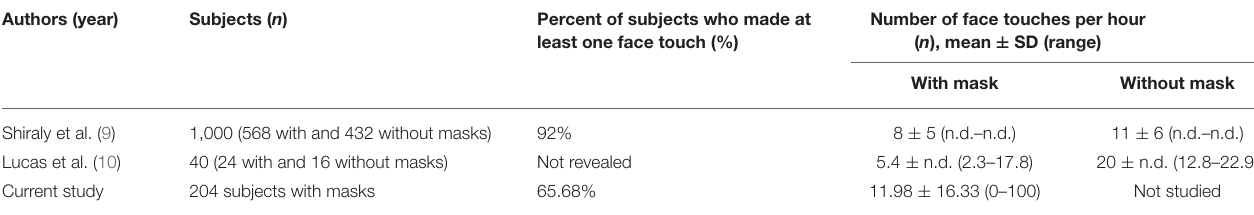
TABLE 2 | Comparison among the series. Authors (year) Subjects ( n ) Percent of subjects who made at Number of face touches per hour least one face touch (%) ( n ), mean ± SD (range) With mask Without mask Shiraly et al. (9) 1,000 (568 with and 432 without masks) 92% 8 ± 5 (n.d.–n.d.) 11 ± 6 (n.d.–n.d.) Lucas et al. (10) 40 (24 with and 16 without masks) Not revealed 5.4 ± n.d. (2.3–17.8) 20 ± n.d. (12.8–22.9) Current study 204 subjects with masks 65.68% 11.98 ± 16.33 (0–100) Not